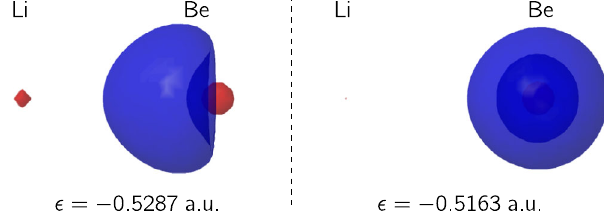
Fig. 6 Symmetry broken LiBe + . Be 2 s -like orbitals in LiBe + at the UHF/6- 311G(p) level, computed at R LiBe = 2.6 Å . Orbital energies are also depicted. Only the left function is actively delocalized over the Li moiety. The isosurfaces shown correspond to ∣ ϕ ∣ = 0.1